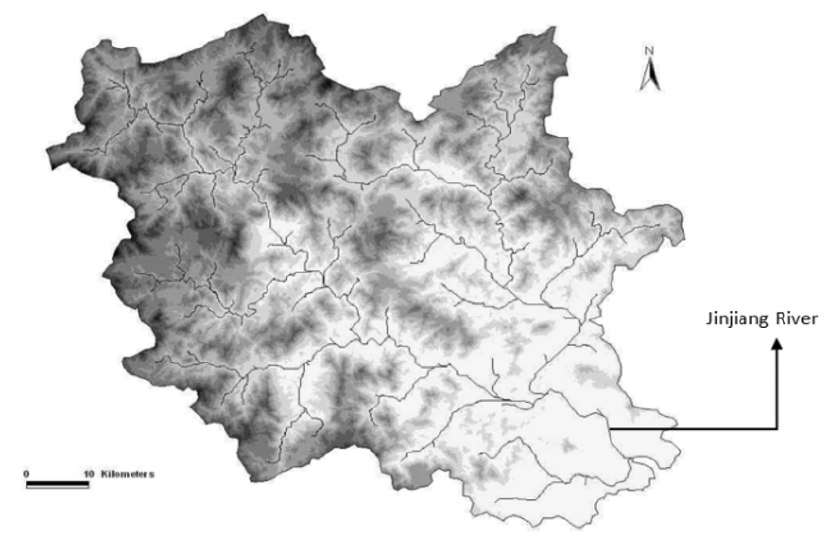
Figure 1. Geographical overview of Jinjiang River